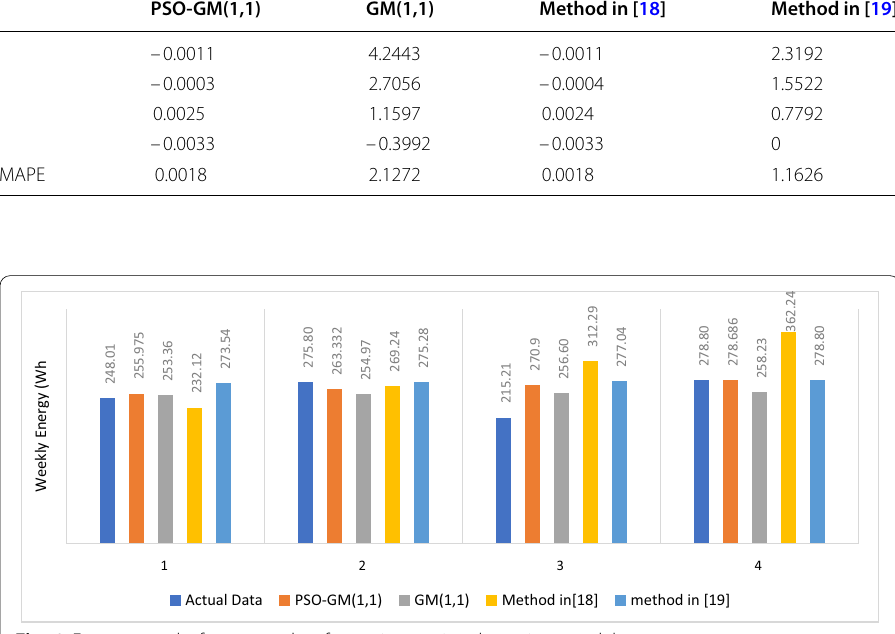
Table 4 Percentage errors associated with forecasts by the various models, for energy data for a desktop computer PSO-GM(1,1) GM(1,1)